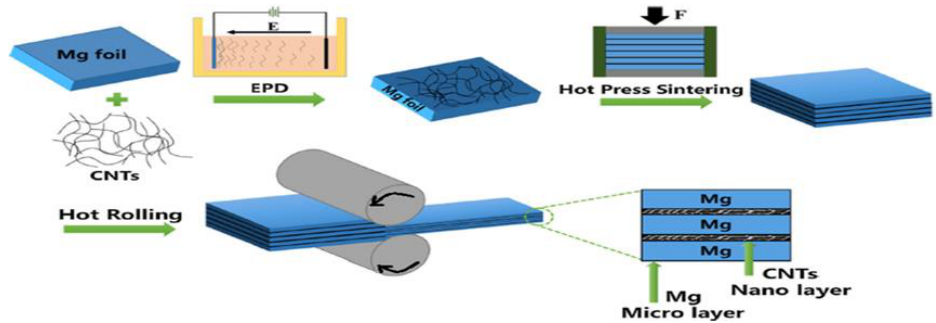
Figure 5. Fabrication of layered micro-nano configuration of CNT-reinforced composites [75].